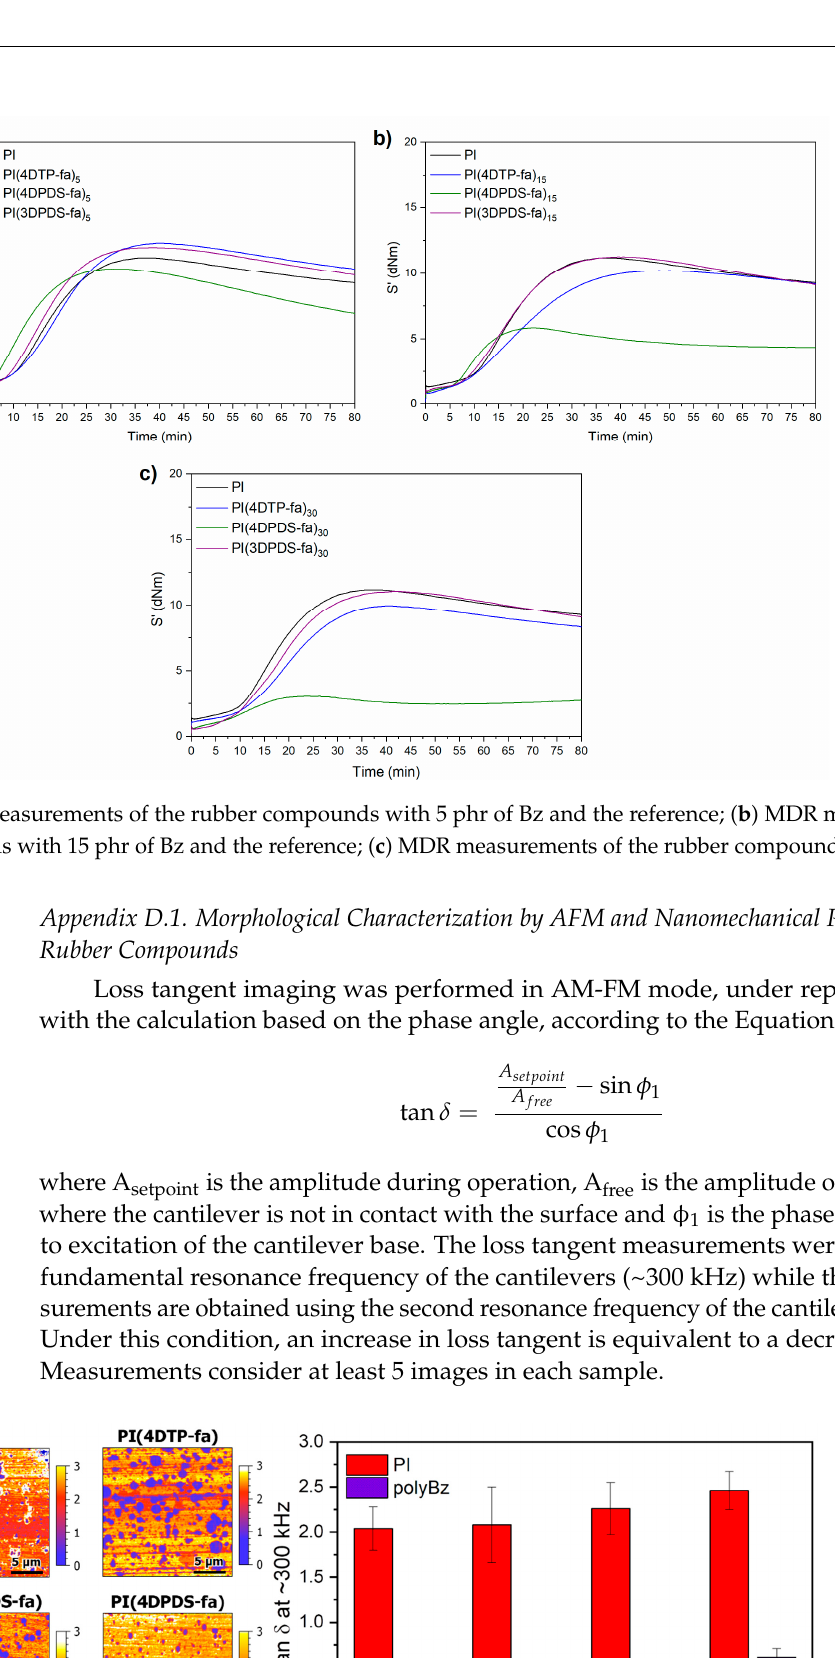
Figure A31. AFM-AM-FM modulus images and respective histograms of ( a ) poly(4DTP-fa), ( b ) poly(4DPDS-fa), and ( c ) poly(3DPDS-fa). Images depict an area of 5 × 5 μ m 2 . Appendix D.2. Tensile Test of Cured Rubber Compounds